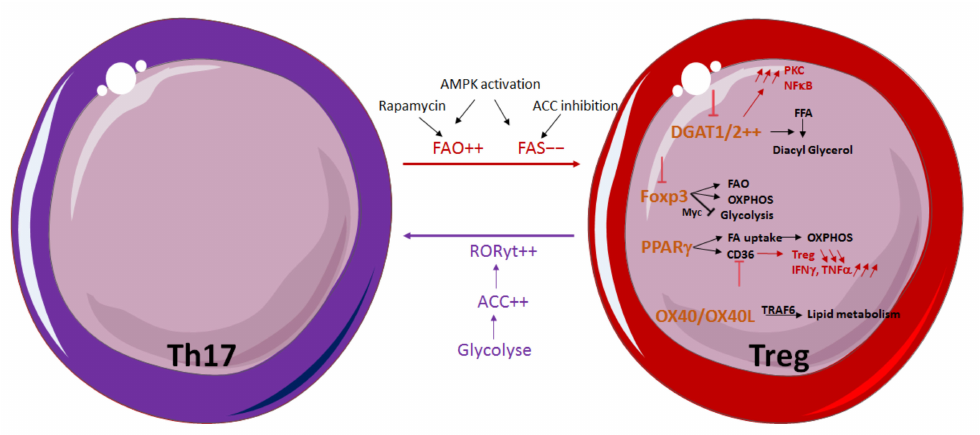
Figure 2. Fatty acid metabolism is involved in Th17/Treg balance. Th17/Treg metabolism is reg- ulated by glycolysis and FAO. In Treg, Foxp3 favors FAS and OXPHOS but decreases glycolysis. DGAT1/2, PPAR γ and OX40/OX40L are involved in FA metabolism in